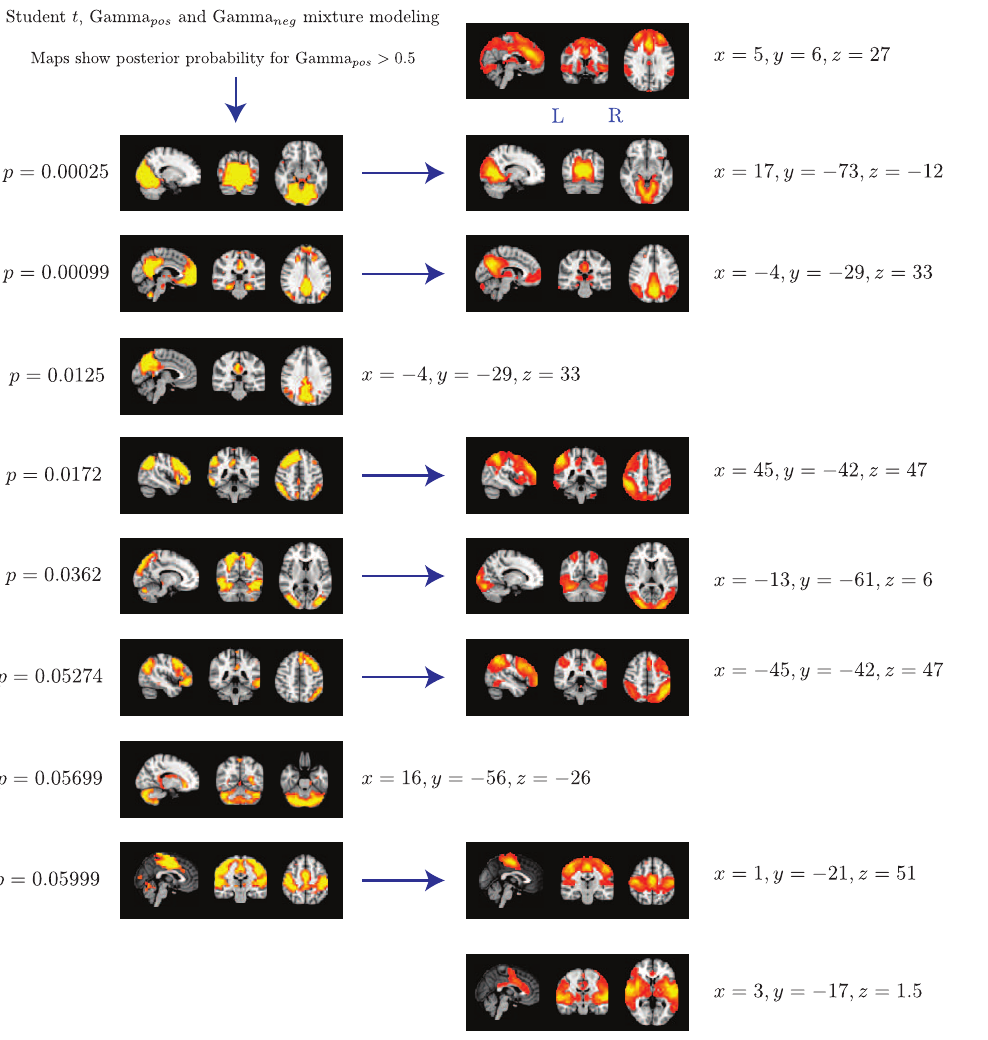
Figure 9. The top 8 ‘‘reproducible’’ ICs from a RAICAR-N analysis on single subject ICA runs compared with standard RSN maps reported in literature [ 8 ] . We are able to declare 4 ‘‘standard’’ RSNs as significantly reproducible at a p -value v 0 : 05 . There are 2 other ‘‘standard’’ RSNs that achieve a reproducibility p -value between 0 : 05 and 0 : 06 as well as 2 ‘‘non-standard’’ RSNs that achieve p -values of 0 : 0125 and 0 : 05699 respectively. We also could not find 2 of the published RSNs in [3] as reproducible in single subject ICA